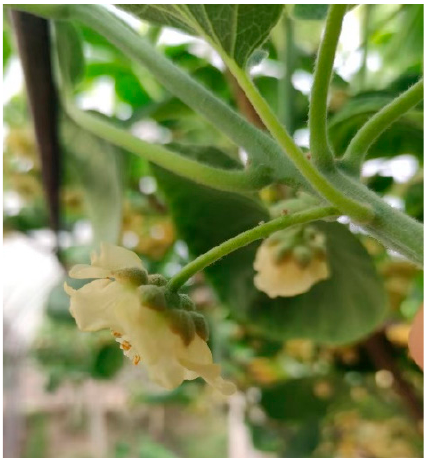
Figure 5. Flower tilt photo.